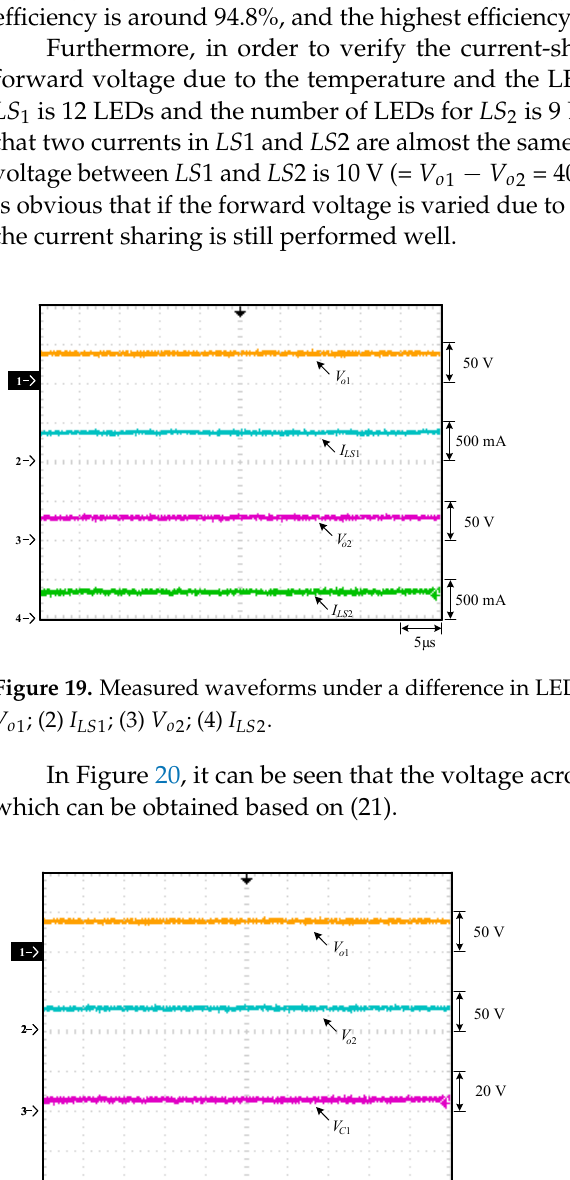
Figure 18. Measured efficiency.